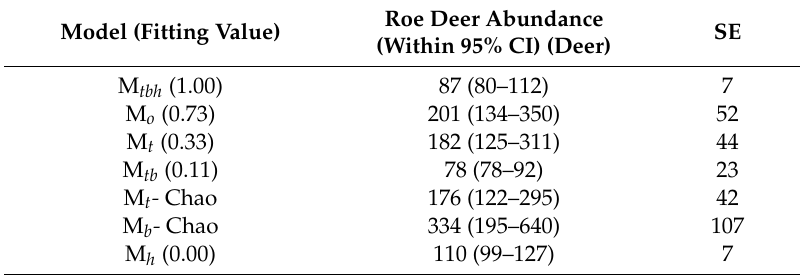
Table 3. Estimated population abundance for Siberian roe deer in Program CAPTURE using the fecal-DNA capture-mark-recapture method in Liangshui National Nature Reserve, China in 2016. Results from di ff erent models in the programs are shown with fitting values in brackets where